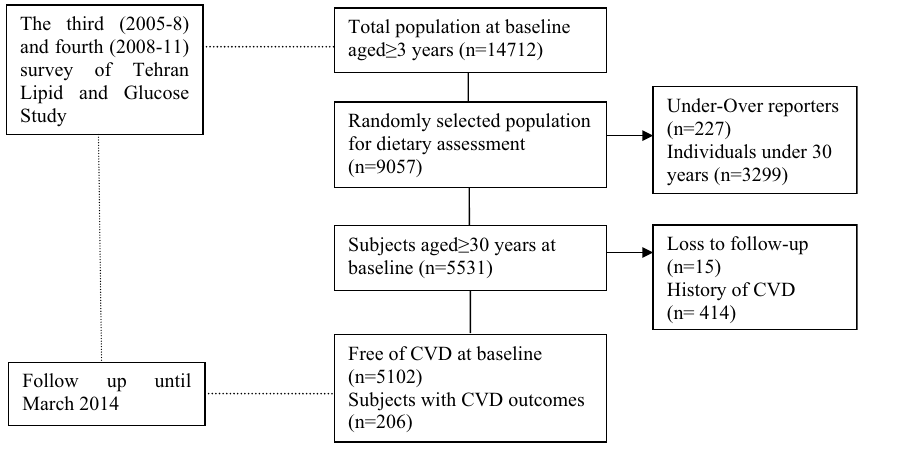
Figure 1. Outline of study participants’